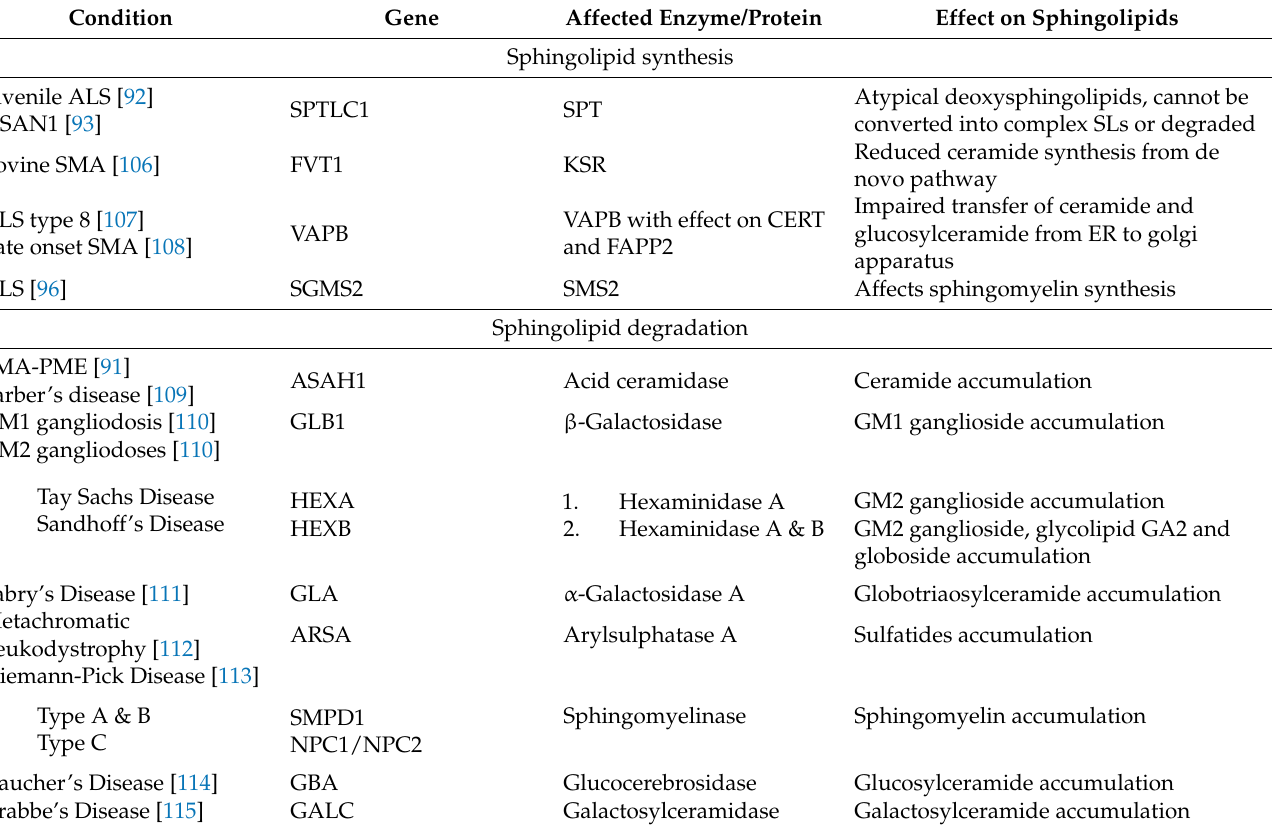
Table 1. Abnormalities of Sphingolipid metabolism in Motor Neuron Diseases and